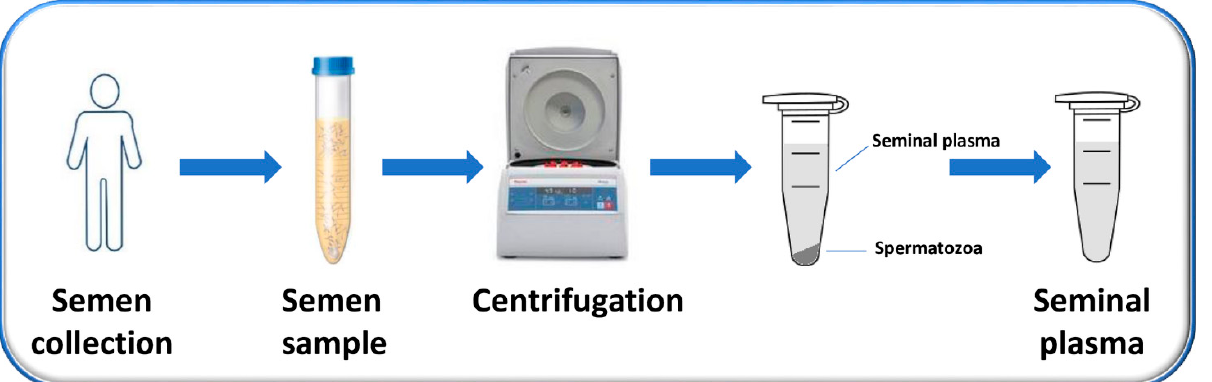
Figure 1. Flow chart of the process used to obtain SP. Semen is collected from men by masturbation into sterile containers after (3 – 5) days of sexual abstinence and is allowed to liquefy. After liquefaction, semen samples are centrifuged to separate the supernatant (representing the SP) from the pellet (composed mainly by the sperm cells).